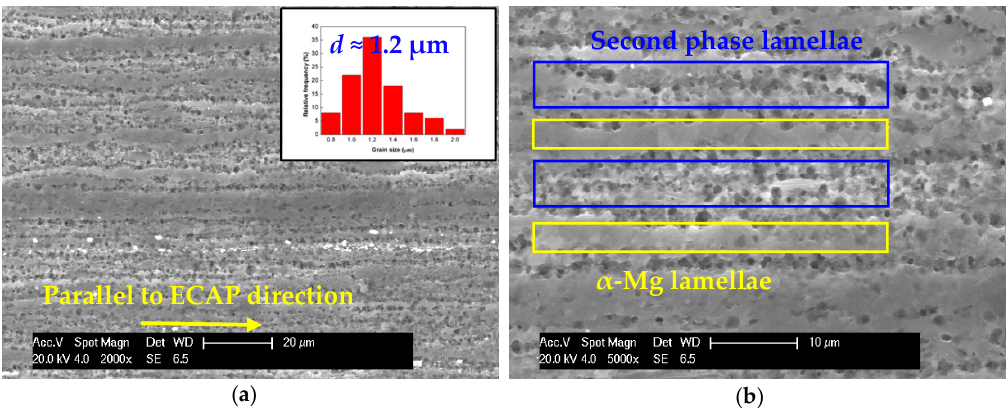
Figure 3. SEM images of ECAP Mg-10Y-6Gd-1.5Zn-0.5Zr alloy at low ( a ) and high ( b ) magnifications (samples were etched with 4 mL nitric acid and 96 mL ethanol).